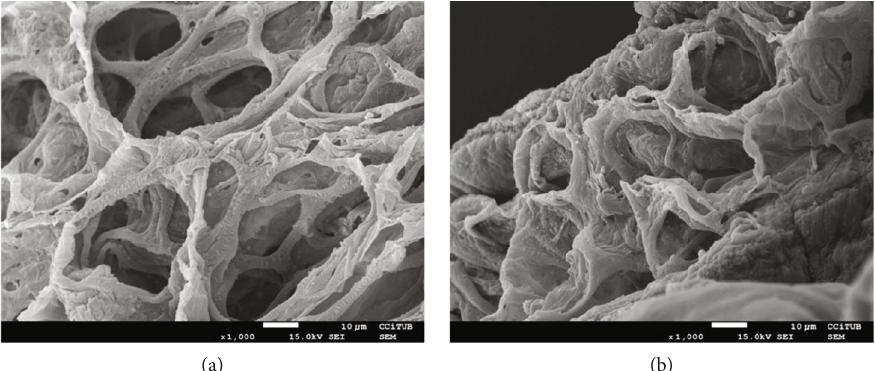
Figure 6: Scanning electron microscopy images of decellularized lungs submitted to photodynamic therapy for one hour with phosphate- bu ff ered saline (a) or photosensitizer protoporphyrin IX (b).